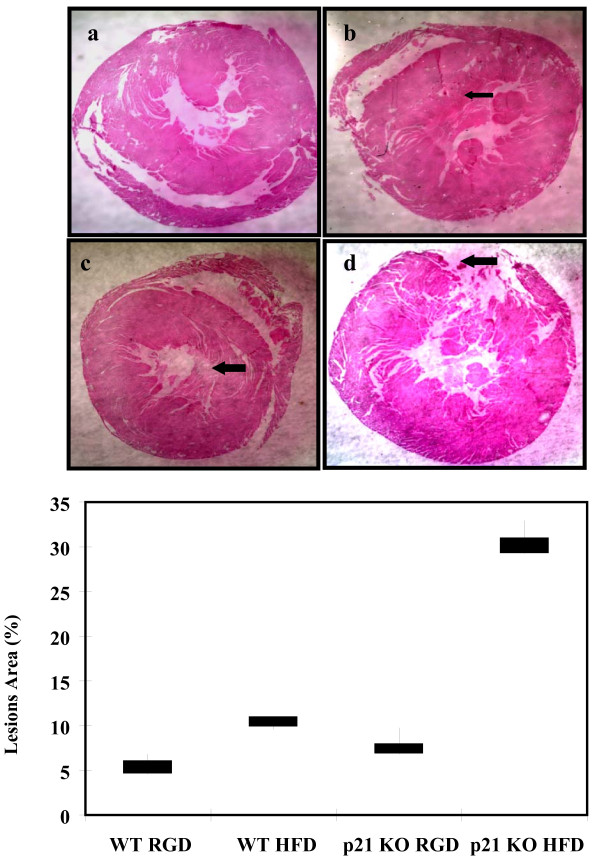
Histology and morophometry of atherosclerotic lesions. Photomicrographs of light microscopy of representative sections of the coronary artery tissues from p21-/- and wild type mice. Magnification is ×20 for all tissues. Haematoxylin and eosin staining of in the coronary artery issues of wild type mice fed with regular diet (a), high fat diet (b); p21-/- mice fed with regular diet (c) and high fat diet (d) is shown. Black arrows indicate areas with scar. The graph (B) shows the mean lesion area (values are Mean ± SEM) per mouse. *p < 0.01, high fat diet (HFD) vs regular diet (RGD), wild type mice and **p < 0.0001, high fat diet vs regular diet in p21-/- mice.